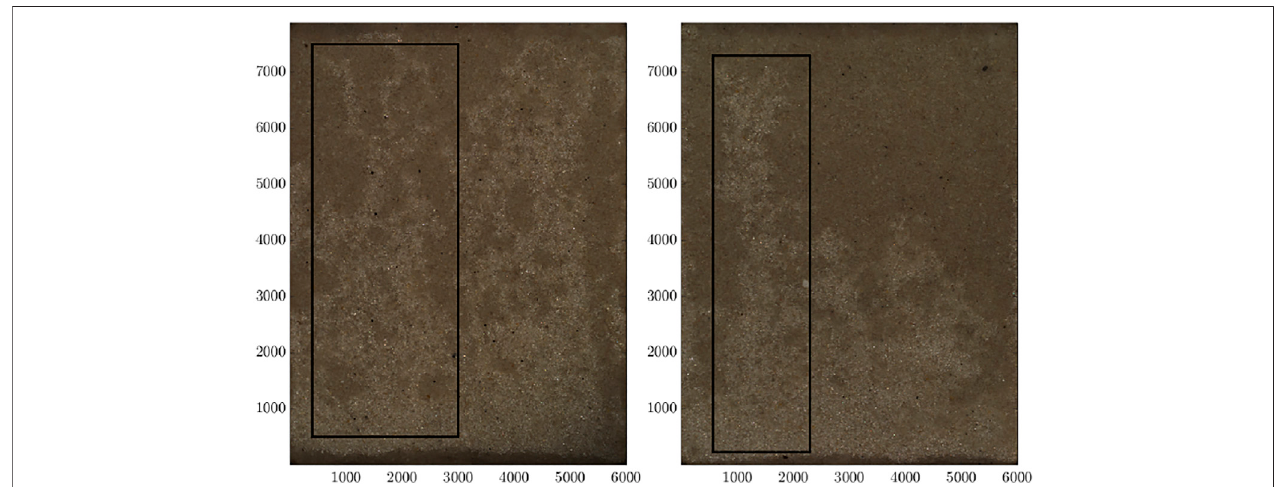
FIGURE 4 | Fontainebleau sand sample invaded by gas: on the left, drainage test (1); on the right, drainage test (2). The size of the image is height = 48.2 mm and width = 36.6 mm. The black rectangle marks the studied zone.